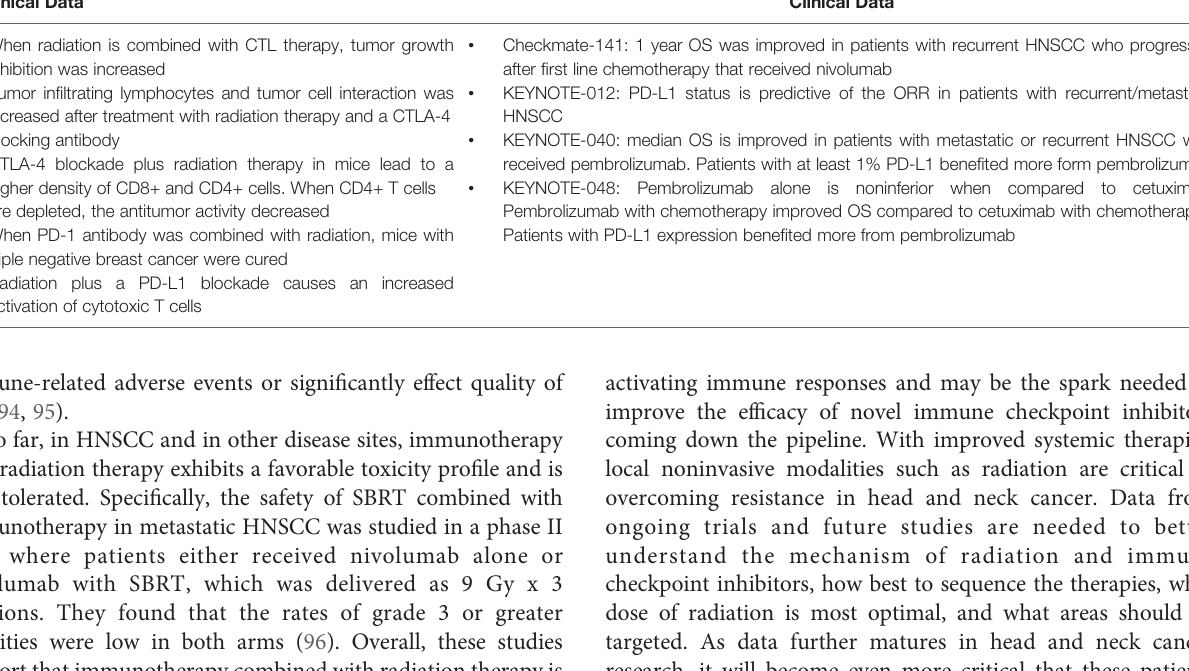
TABLE 2 | Select Preclinical and Clinical Data Summary. Preclinical Data Clinical